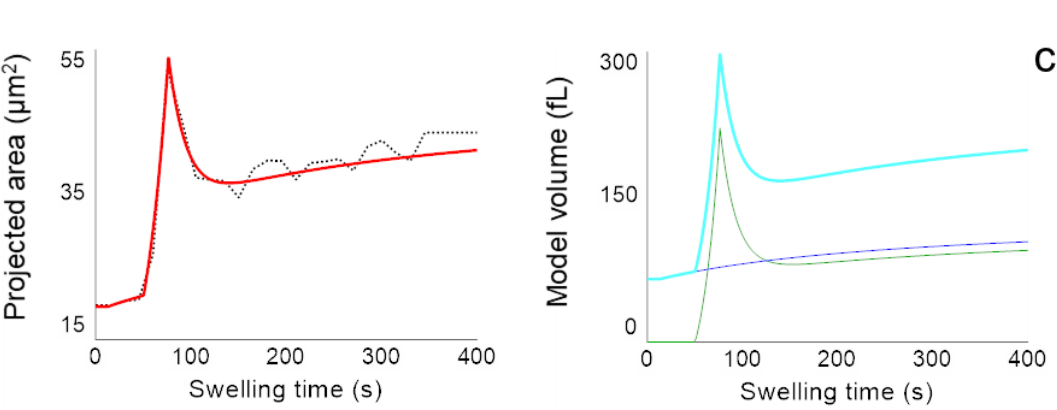
Figure 5. Simulation of swelling kinetics with a parallel dynamic model (red curve, left ) based on the change of corresponding volumes (blue curve: volume I; green curve: volume II; cyan curve: total volume; right ) for individual CMPs ( a ) at pH 11 after TGase treatment for 1 h; ( b ) at pH 14 after TGase treatment for 1 h and ( c ) at pH 14 after TGase treatment for 4 h.